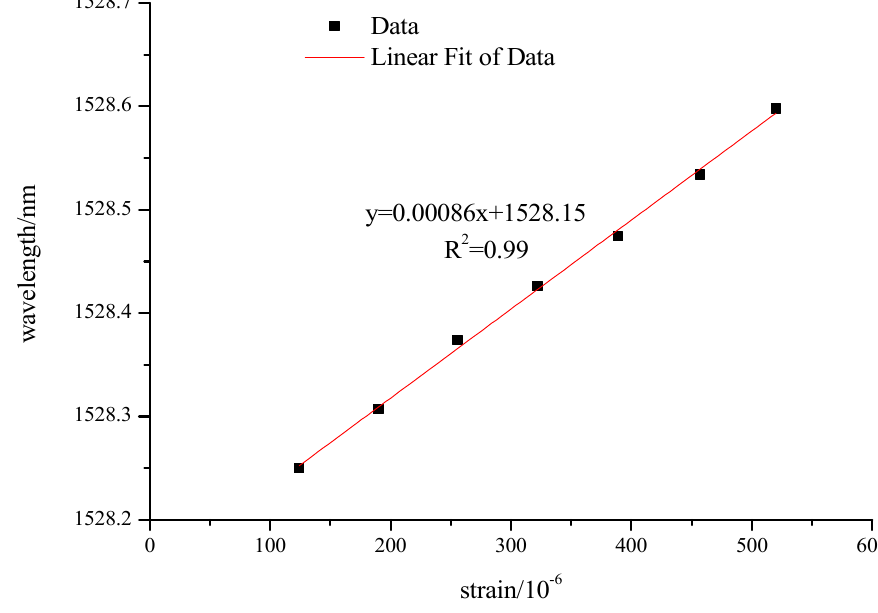
Figure 9. Calibration curve from tests on a clamped FBG sensor.